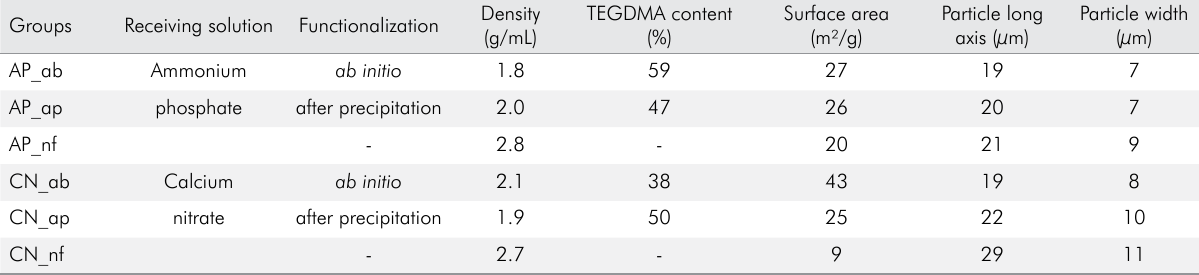
Table 1. Characterization of DCPD particles according to synthesis conditions.